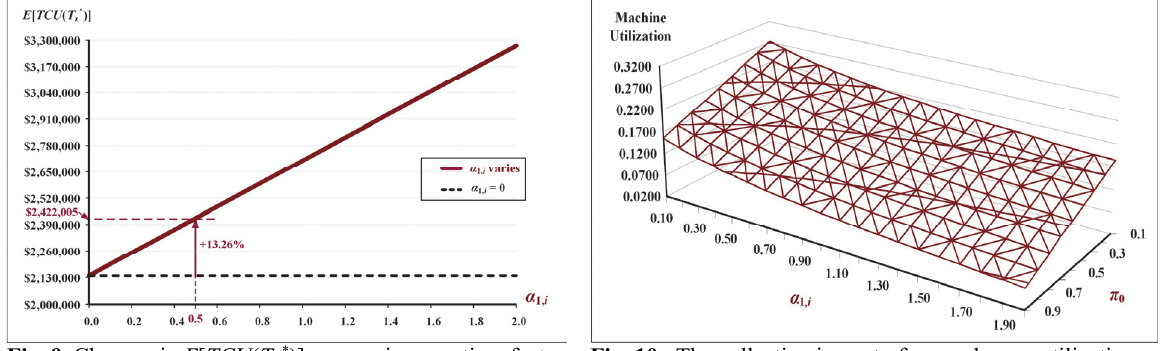
Fig. 9 Changes in E [ TCU ( T Z* )] concerning overtime factor Fig. 10. The collective impact of α 1, i and π 0 on utilization